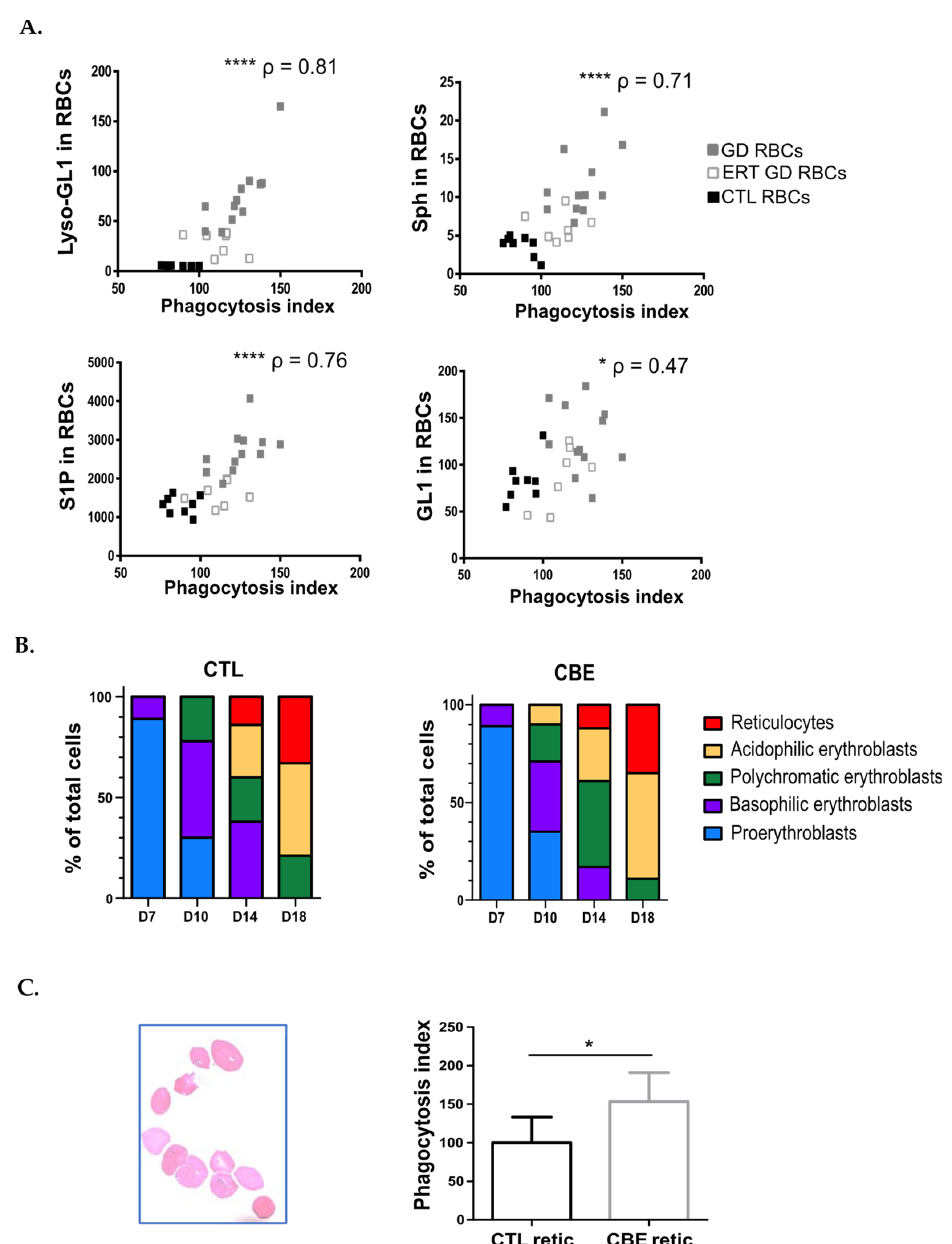
Figure 3. Sphingolipids overload of RBCs enhances their erythrophagocytosis. ( A ) Positive correla- tions between the PI and the sphingolipids content measured in RBCs (Lyso-GL1, Sph, S1P, and GL1). GD, ERT GD, and CTL RBCs values are depicted with gray, white and dark squares, respec- tively. The p and ρ values were determined using the Spearman rank correlation test. * p < 0.05; **** p < 0.0001. ( B ) Proportion of erythroid progenitors on days 7, 10, 14, and 18 of the erythroid differ- entiation performed without (left panel) or with CBE (right panel). Morphological analysis after May-Grünwald-Giemsa (MGG) staining was analyzed. ( C ) Left panel: Observation after MGG stain- ing of reticulocytes sorted after 18-days of erythroid differentiation. Right panel: Erythrophagocy- tosis assays were performed using THP1-derived macrophages co-incubated with sorted reticulo- cytes obtained after 18 days of erythroid differentiation without (CTL retic; n = 5) or with (CBE retic; n = 5) CBE. The chart represents the PI. The means and standard deviation are represented. Group comparison was performed using a Mann-Whitney test. * p < 0.05.